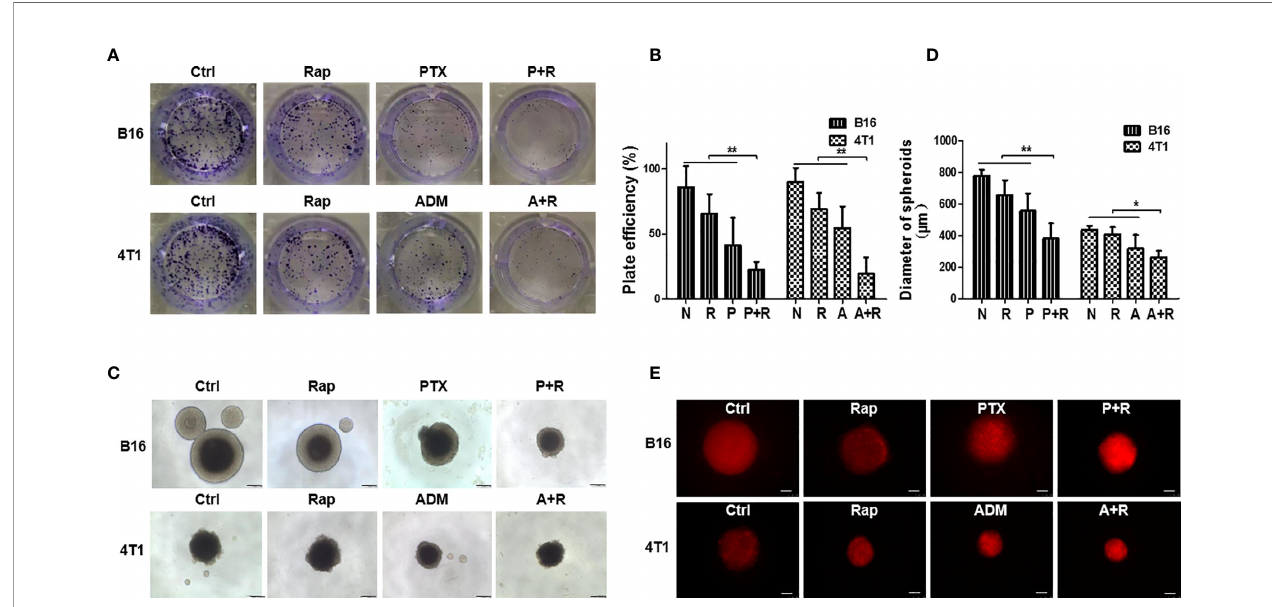
FIGURE 1 | Rapamycin enhanced the inhibitory effects of chemotherapy on B16F10/4T1 cancer cell proliferation and induction of cell death. (A) Colony-formation assay for the proliferation of B16F10 and 4T1 cells under different drug treatments. (B) Graph of the statistical analysis of the plating ef fi ciency. (C) Spheroid formation was used to evaluate tumor cell proliferation in 3D cultures (scale bars: 200 m m). (D) Graph of the statistical analysis of spheroid diameter. (E) Autophagy- associated death of cancer cell spheroids was measured by propidium iodide (PI) staining and imaged using red fl uorescence (scale bars: 250 m m). B16: B16F10. Ctrl: negative control group. Rap: rapamycin. P+R, PTX+Rap; A+R, ADM+Rap. Bars and error bars represent means ± SD, respectively, of three independent experiments. * P < 0.05, ** P < 0.01 by Student ’ s t